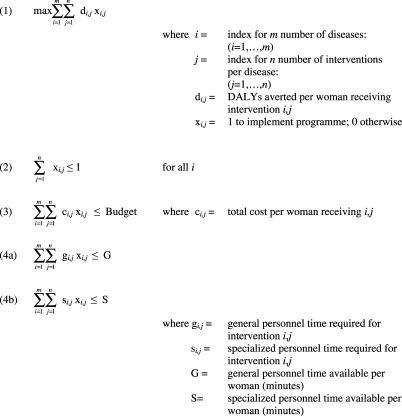
Equations of the Integer Programming ModelThe IP model consists of the objective function, which maximizes DALYs averted through the health interventions (equation 1); the constraint of choosing no more than one intervention option per disease (equation 2); a budget constraint, expressed as a per-woman lifetime health expenditure (equation 3); and human resource constraints, limiting the available general (equation 4a) and specialized (equation 4b) personnel time separately.